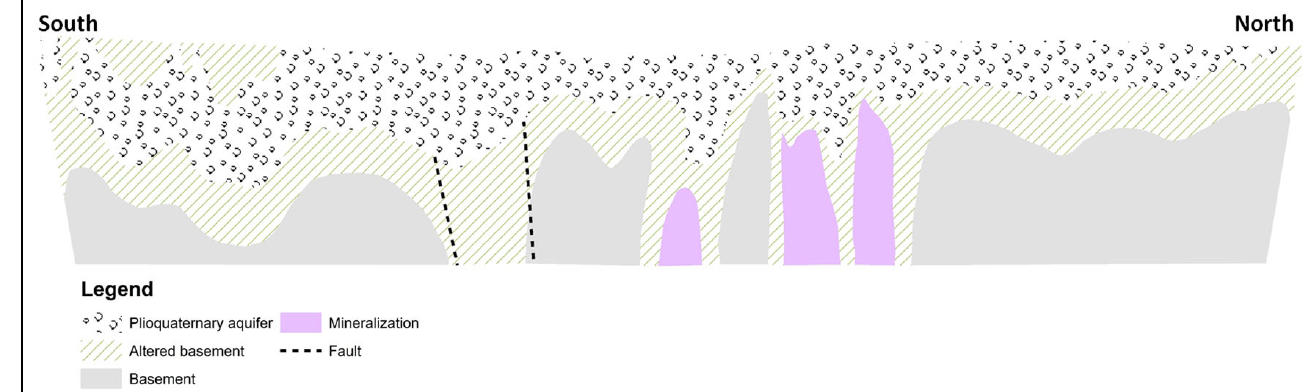
Figure 3. Geohydrological conceptual model of the study area.